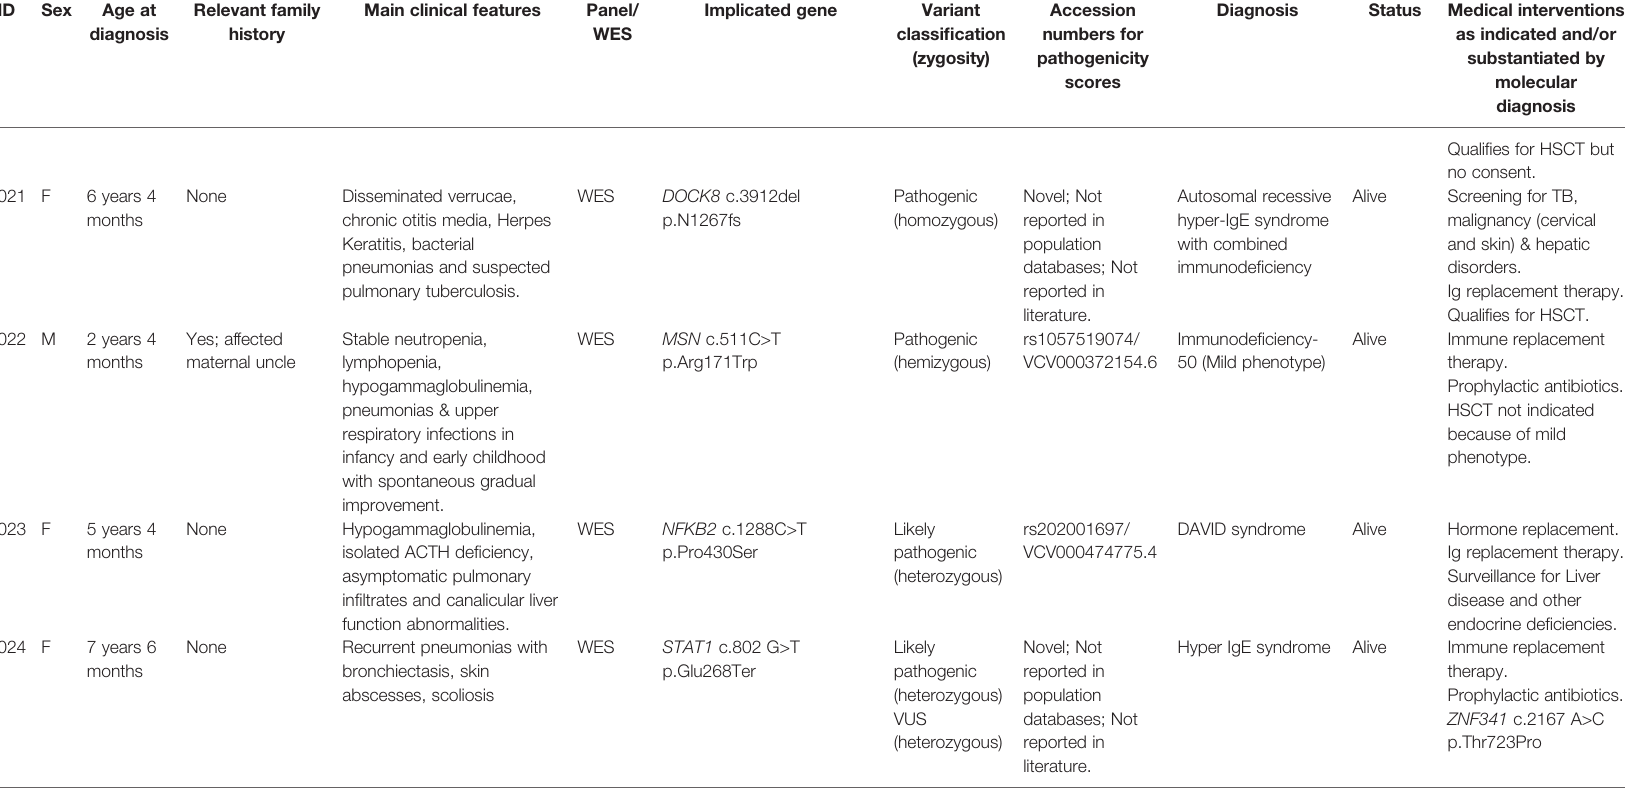
Panel 1 , PR08100.02: Invitae Primary Immunode fi ciency Panel; Panel 2 , PR08111.02.1: Add-on Hypogammaglobulinemia Genes; Panel 3 , PR08111.02.2: Add-on Common Variable Immunode fi ciency Genes; Panel 4 , PR08111.02:Invitae Agammaglobulinemia Panel; Panel 5 , PR08113.01:Invitae Hyper IgE Syndrome Panel; Panel 6 , PR08137.02: Invitae Combined Immunode fi ciency (CID) Panel; Panel 7 , PR08143.02:Invitae Mendelian Susceptibility to Mycobacterial Disease Panel; Panel 8 , PR08112.01: Invitae Common Variable Immunode fi ciency Panel; Panel 9 , PR08112.01.1: Add-on Genes for Primary Immunode fi ciencies That Can Mimic Common Variable Immunode fi ciency; Panel 10 , PR08114.01: Invitae Hyper IgM Syndrome Panel; Panel 11 , PR08114.01.1: Add-on Clinically-overlapping Genes; Panel 12 , PR08120.02.01: Add-on Autoimmunity Genes; Panel 13 , PR08120.02: Invitae Autoin fl ammatory Syndromes Panel; Panel 14 ,